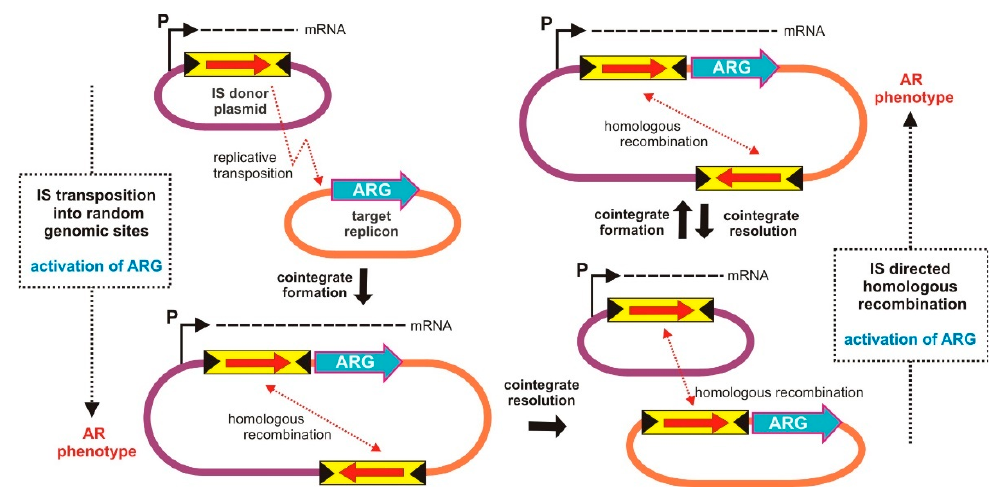
Figure 4. Periodic activation of a transcriptionally silent AR gene by promoters delivered through the formation of cointegrates. ARG—antibiotic resistance gene; P —promoter. Replicative transposition of an IS results in formation of a cointegrate between the IS (and promoter) donor and ARG-containing recipient replicons. Homologous recombination leads to resolution of the cointegrate plasmid into two independent IS-containing replicons. Further IS homology directed recombination events lead to the generation of a cointegrate replicon to produce the AR phenotype.